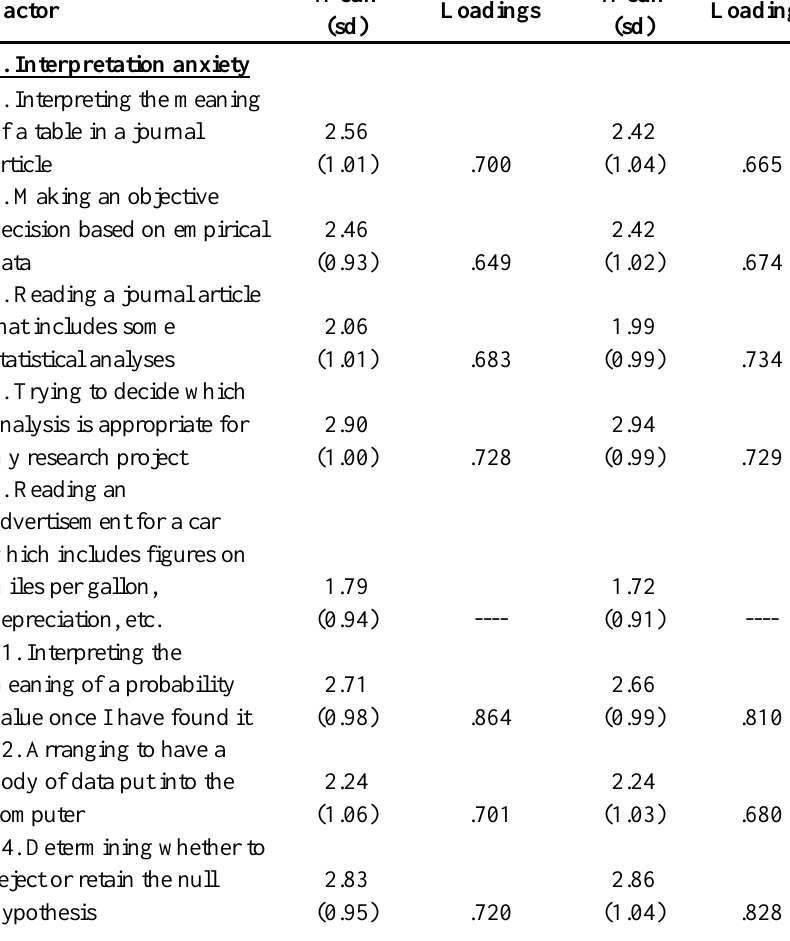
Six-factors factorial structure for “training” and “validation” samples